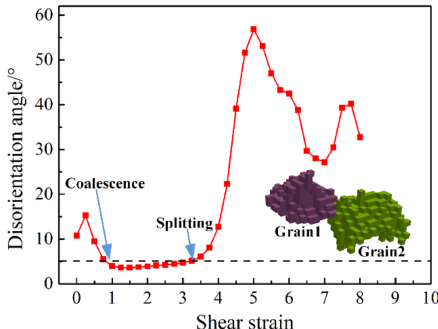
Figure 10. Simulated volume fractions of coalescing grains ( a ) and texture index ( b ) for three kinds of initial textures in simple shear as a function of strain.